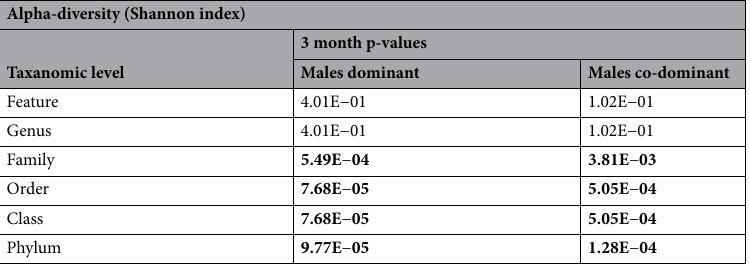
Table 1. Microbiome alpha-diversity was significantly associated with APOE status in 3-month male but not female mice. P-values reflect nominal p-values and were determined using Kruskal–Wallis tests. Values for 5- and 7-month male mice and female mice are presented in Tables S1 and S2. Raw data for alpha-diversity indices are provided in Supplemental Files. Significance p-values are in bold font.